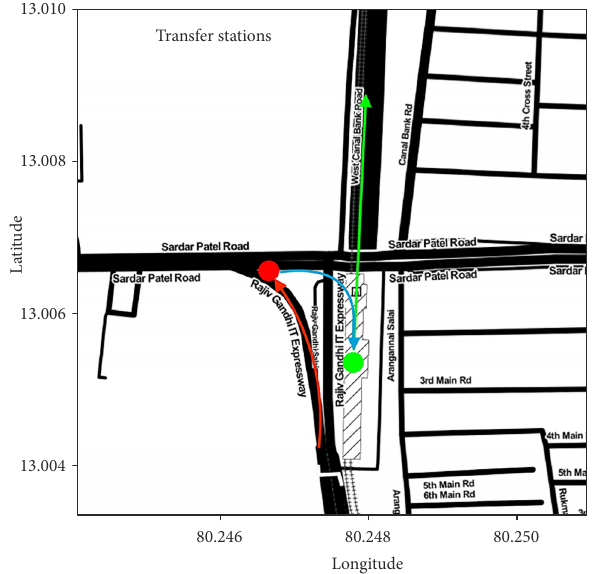
Figure 10. A map denoting the transfer points for a sample